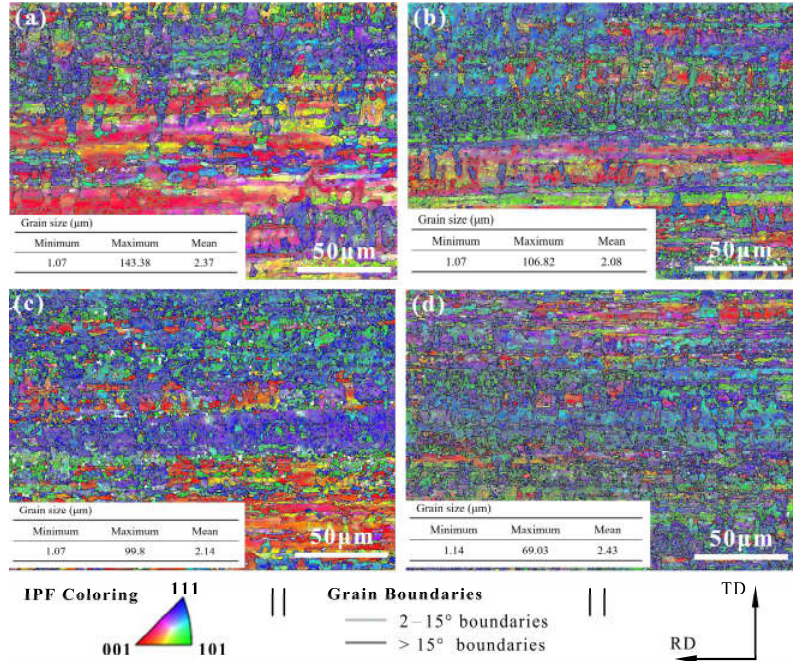
Figure 5. EBSD results at various DCT times of ( a ) 0 h, ( b ) 12 h, ( c ) 24 h, and ( d ) 24 h. The grain orientation and the frequency of misorientation angle during the DCT pro- cess are shown in Table 2. Table 2. The results of the recrystallized fraction and the grain orientation fraction.